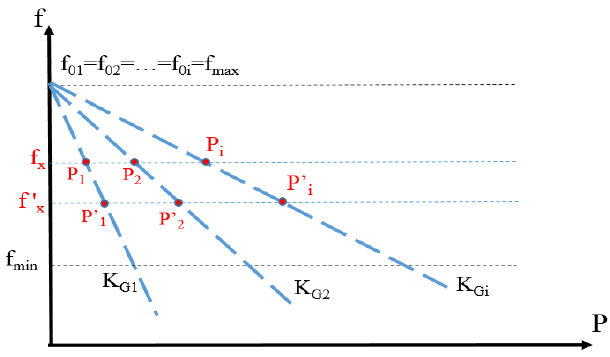
Figure 2. Power sharing with conventional droop control method.